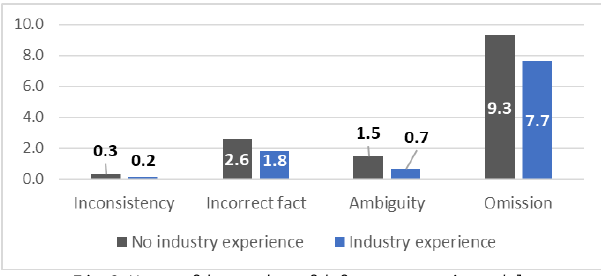
Fig. 8. Mean of the number of defects per type in